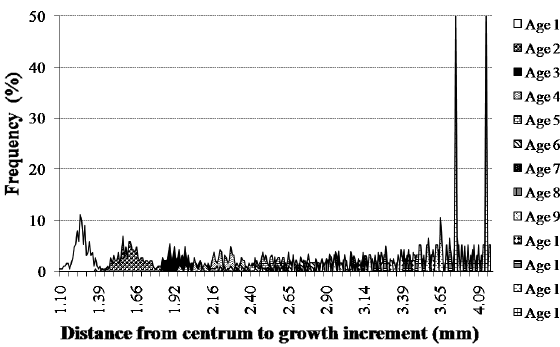
Fig . 4. – Vertebra from a specimen of Aphanopus carbo caught off mainland Portugal, with 1036 mm total length and 6 years. Black dots represent growth increments. C, centrum.